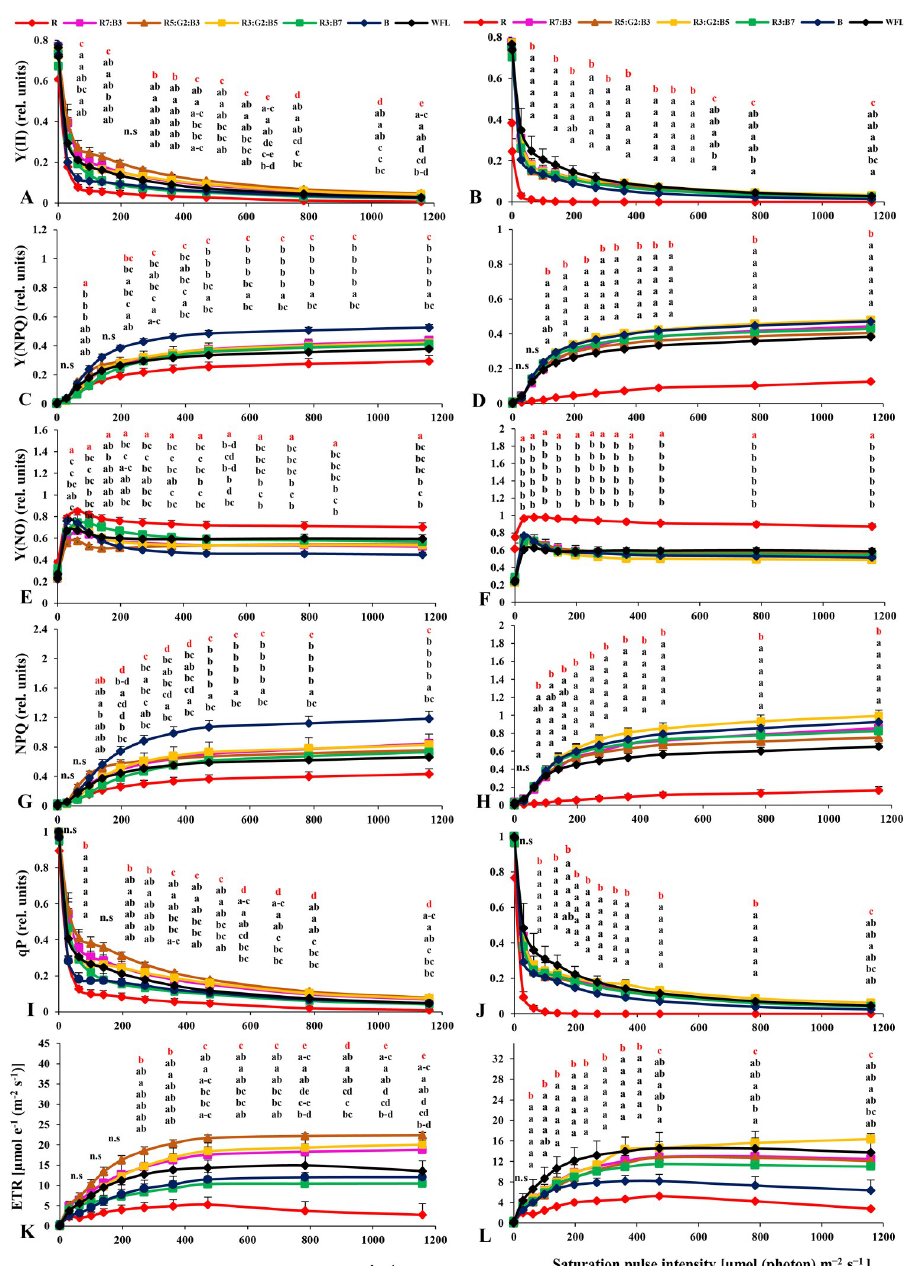
Fig 4. Effects of LED light quality on RLC of the light-acclimated tomato plants. A and B: effective quantum yield of PSII photochemistry Y(II), C and D: quantum yield of regulatory energy dissipation in PSII Y(NPQ), E and F: quantum yield of non-regulated energy dissipation in PSII Y(NO), G and H: non-photochemical quenching (NPQ), I and J: photochemical quenching coefficient (qP), and K and L: electron transport rate (ETR) in tomato leaves. Gangmu No.1 (A,C,E,G,I,K) and Millennium (B,D,F,H,J,L). Line markers on the curves indicate to the average ± standard error (P � 0.05, n = 4). Sort significance letters from top to bottom according to the treatments (R, R7:B3, R5:G2:B3, R3:G2: B5, R3:B7, B, WFL). Where R = Red light 100%, R7:B3 = Red70%+ Blue30%, R5:G2:B3 = Red50%+Green20% + Blue30%, R3:G2:B5 = Red30%+Green20%+ Blue50%, R3:B7 = Red70%+ Blue30%, B = Blue light 100%, WFL = White Fluorescent